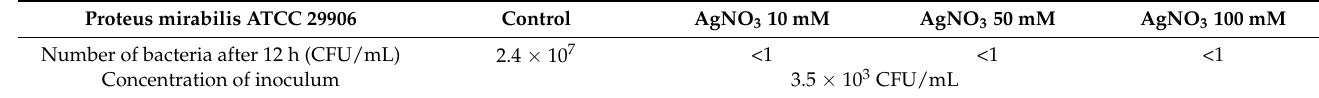
Table 1. Antibacterial test using Proteus mirabilis